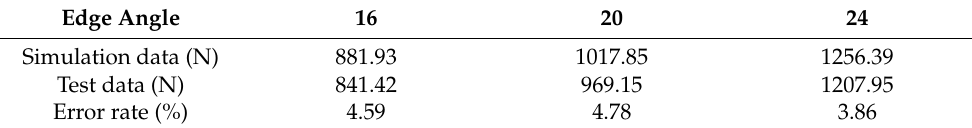
Table 3. Comparison of measured and simulated maximum cutting force at 90 ◦ , 5 mm · s − 1 .